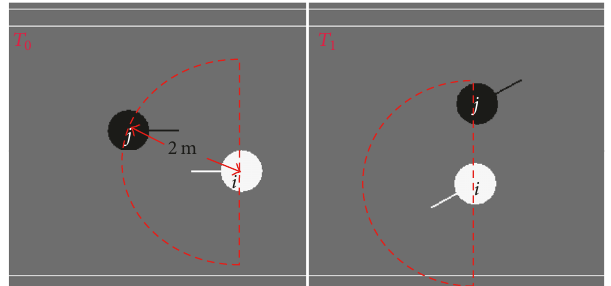
Figure 8: The definition of the collision-avoidance time: when pedestrian 𝑗 walks into the search scope of collision avoidance of pedestrian 𝑖 and the relative position 𝑙 𝑖𝑗 < 𝑟 𝑖 + 𝑟 𝑗 , we record the time 𝑇 𝑗 walks out of the search scope, we record the time 𝑇 0 . When 1 = 𝑇 − 𝑇 and the collision-avoidance time 𝑇 1 0 . According to the ca experimental results, we define the search radius as 𝑙 𝑖 = 2 m.